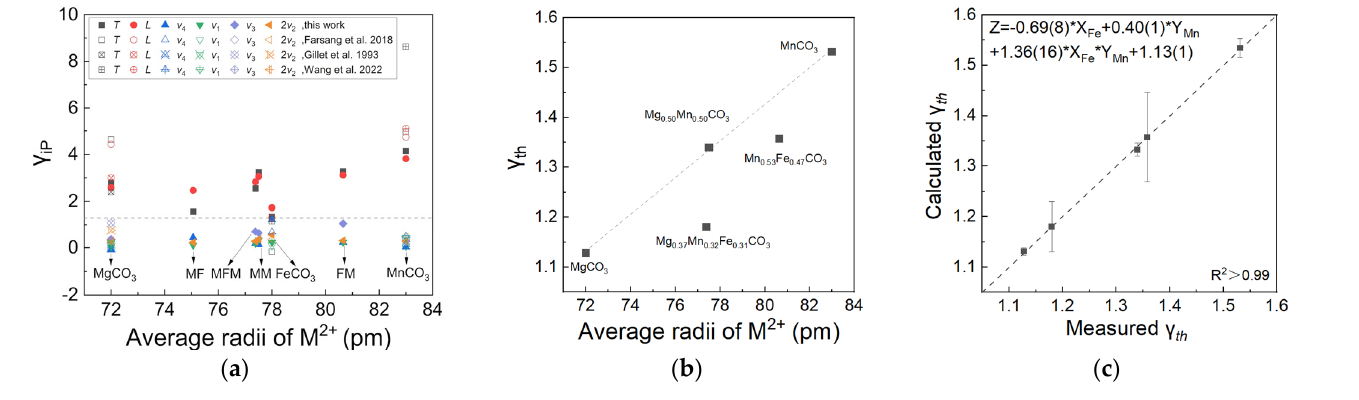
Figure 6. ( a ) The mode Grüneisen parameters γ i,P of each variational mode of MFM, MF, FM, MM, MgCO 3 , FeCO 3 , and MnCO 3 in this work and literature. Data from Farsang et al., 2018, Gillet et al., 1993, and Wang et al., 2022 [6,8,29]. The values of the mode Grüneisen parameters γ i,P of external lattice vibrations ( T , L mode) are greater than the internal vibrations (below the grey dash line), except for the ν 4 mode of FeCO 3 . ( b ) The thermal Grüneisen parameters with the change of the av- erage ion radius of MFM, FM, MM, MgCO 3 , and MnCO 3 . ( c ) The equation of Fe 2+ and Mn 2+ contents and the thermal Grüneisen parameters.